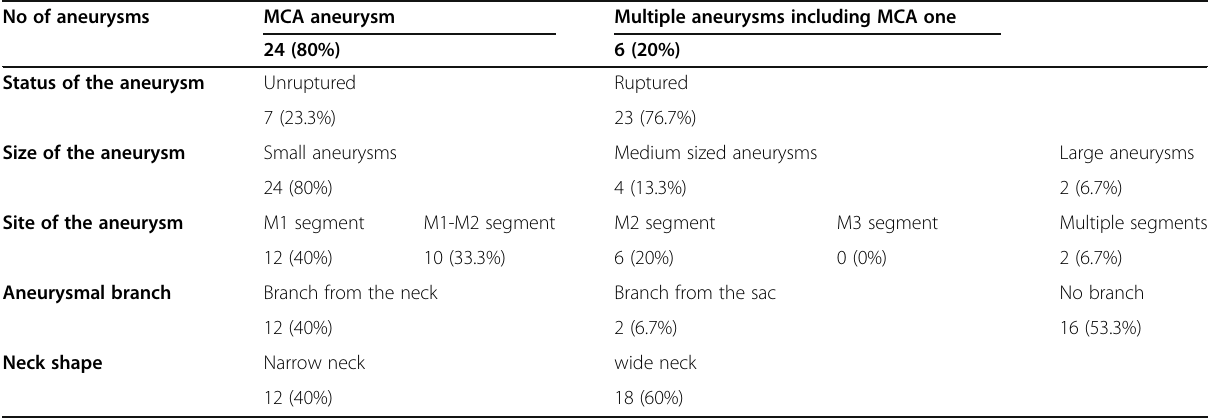
Table 1 Aneurysm characteristics among the treated